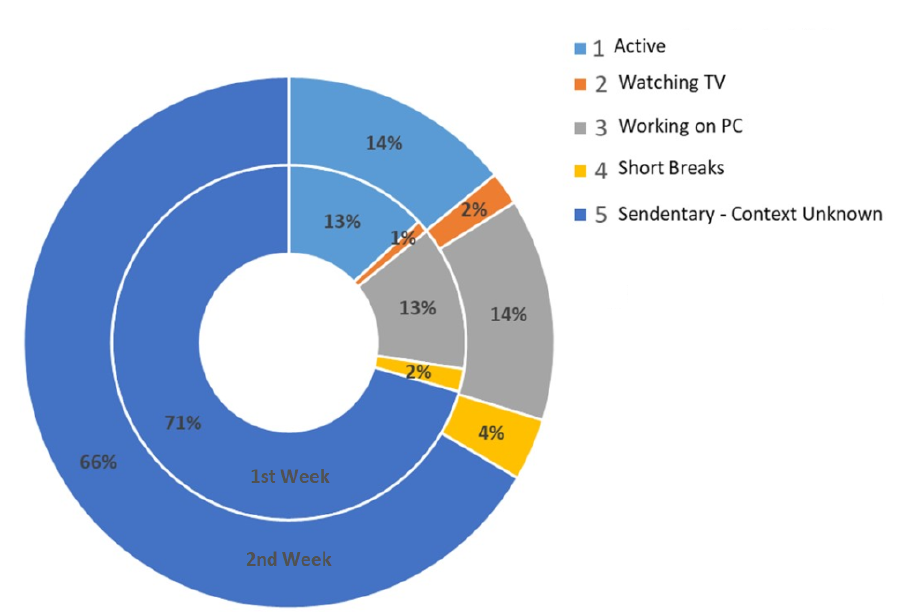
Figure 15. Two-week comparison of the mining